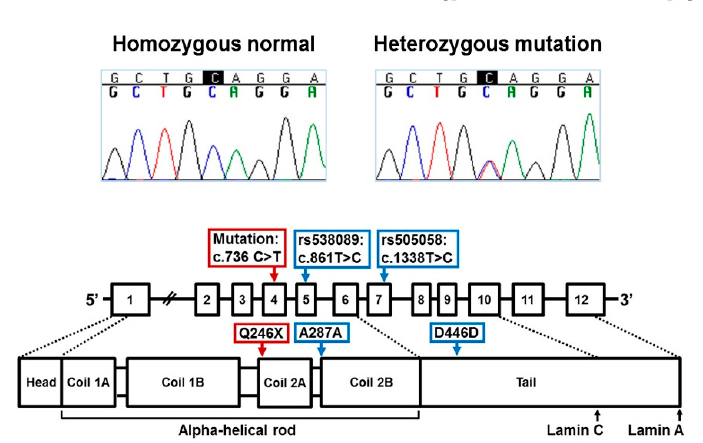
Figure 3. LMNA c.736C>T (p.Gln246Stop). Top panel shows the Sanger sequencing chromatograms: normal allele for unaffected individuals and heterozygous mutation for affected individuals. Bottom panel depicts the location of the nonsense mutation and two expressed polymorphisms rs538089 (c.861T>C, Ala287Ala) and rs505058 (c.1338T>C, Asp446Asp) in the mRNA and Lamin A/C protein.